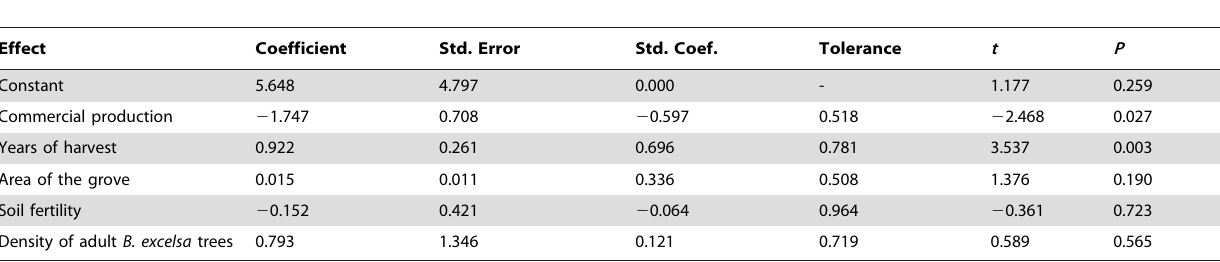
Table 1. Results of multiple regressions testing the effects of Brazil nut harvesting on the density of B. excelsa seedlings in 20 B. excelsa groves located in Kayapo´ Indigenous Land, southeastern